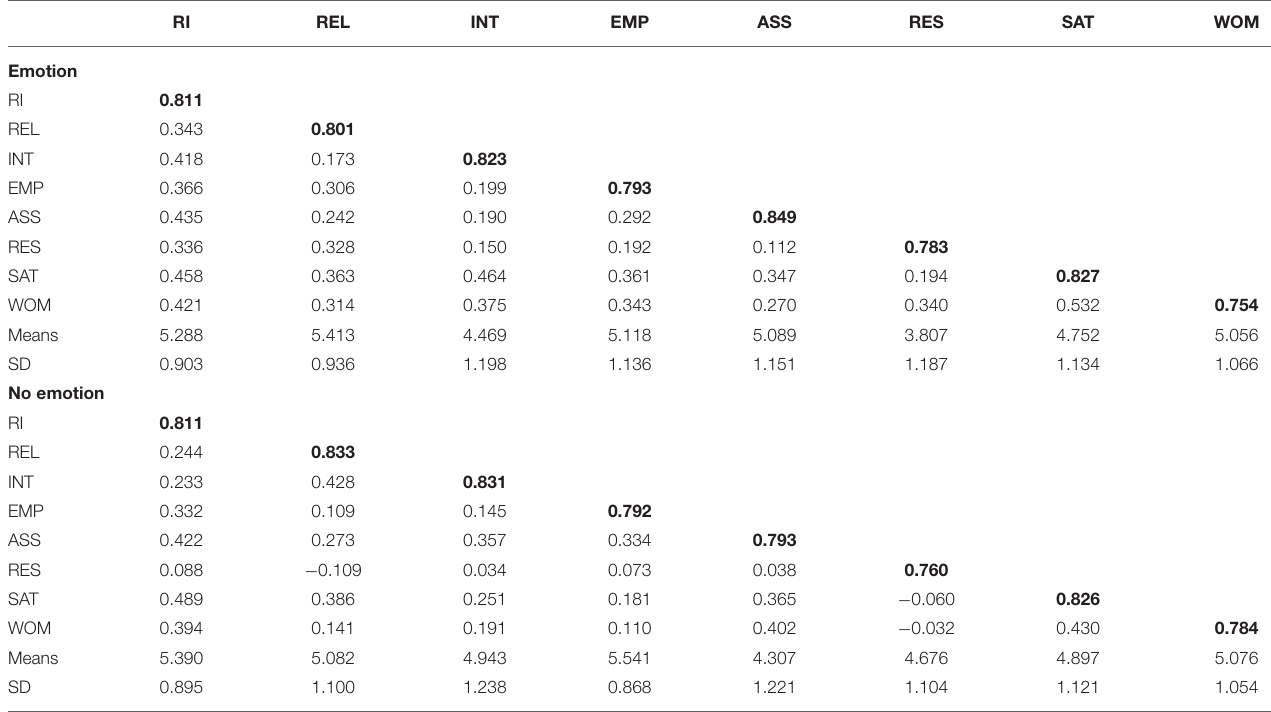
TABLE 4 | Construct means, standard deviations, and correlations.